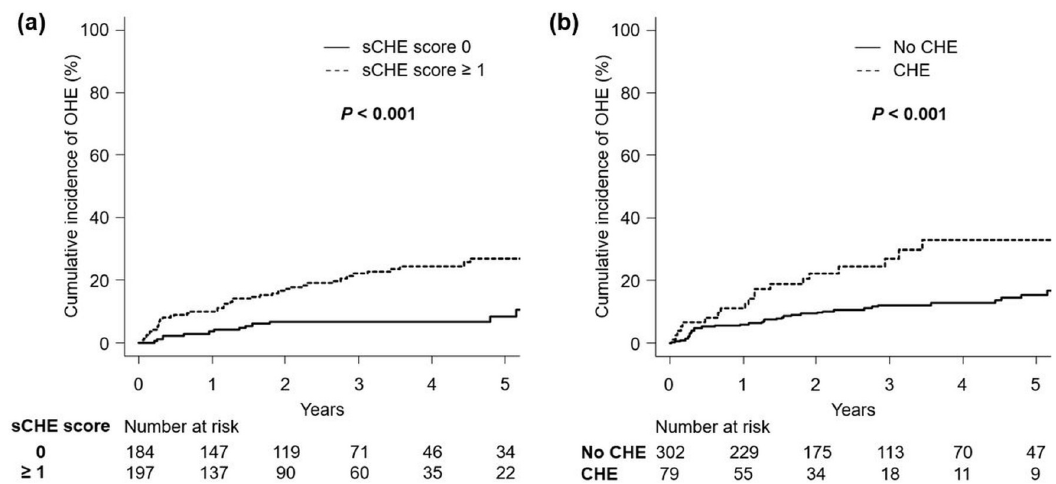
Fig 2. Cumulative incidence of OHE in (a) patients with sCHE score 0 and � 1 and (b) those with and without CHE. The cumulative incidence was estimated using the cumulative incidence function and compared between the groups using Gray’s test. Abbreviations: CHE, covert hepatic encephalopathy; OHE, overt hepatic encephalopathy; sCHE, simple covert hepatic encephalopathy.